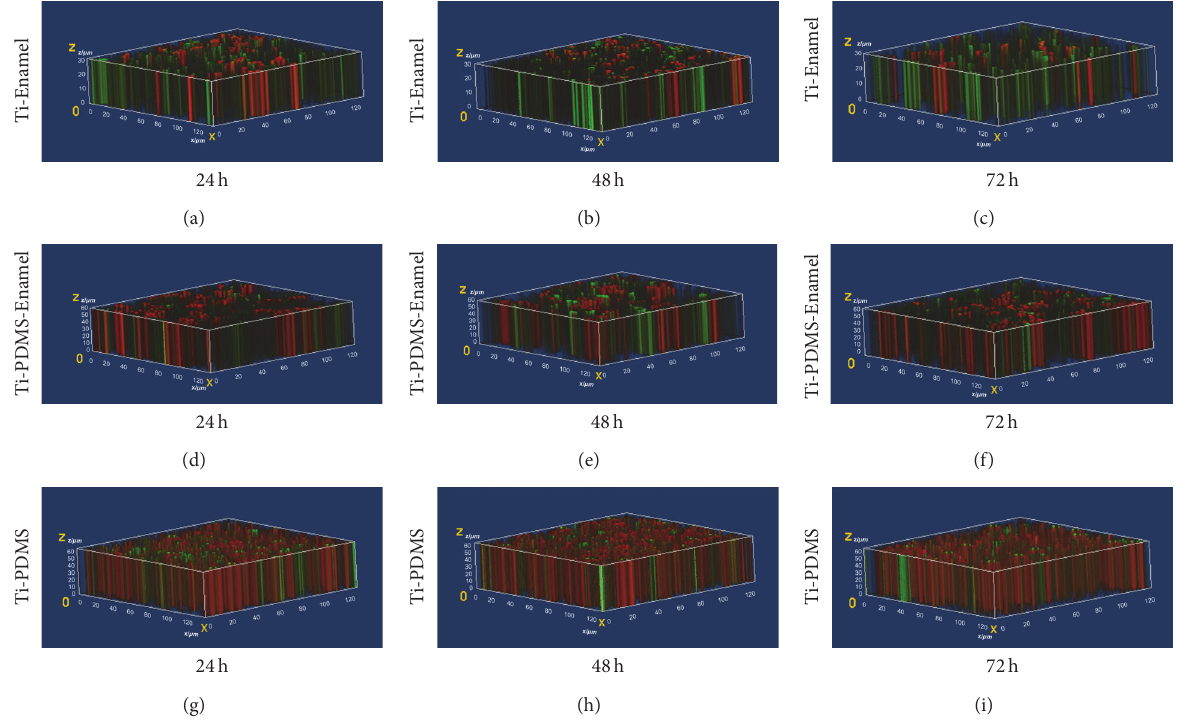
Figure 10: Three-dimensional reconstruction of C. albicans biofilms developed on different substrates at various time intervals using confocal microscopy. (a) C. albicans biofilm development on Ti-Enamel layer after 24 h; (b) C. albicans biofilm development on Ti-Enamel layer after 48 h; (c) C. albicans development on Ti-Enamel composite layer after 72 h; (d) C. albicans development on Ti-PDMS-Enamel layer after 24 h; (e) C. albicans development on Ti-PDMS-Enamel layer after 48 h; (f) C. albicans development on Ti-PDMS-Enamel layer after 72 h; (h) C. albicans layer after 48h; (i) C. albicans development on Ti-PDM layer after 72